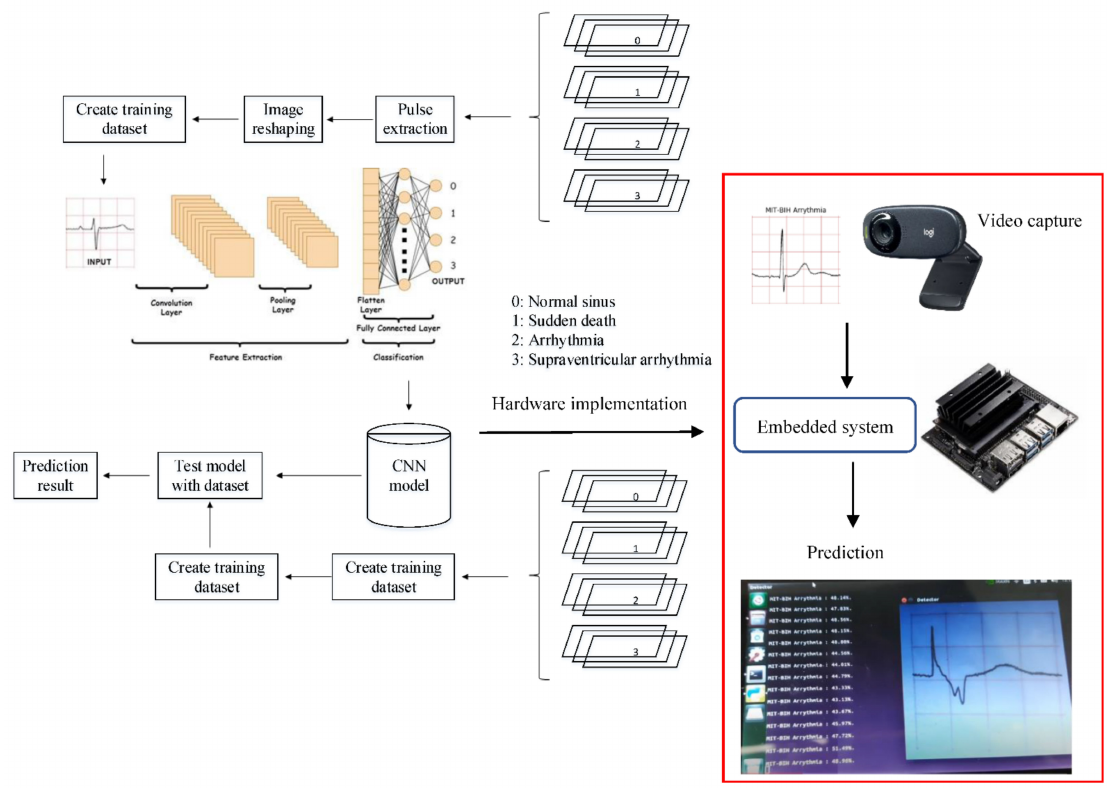
Figure 17. Online and real-time ECG image prediction in hardware